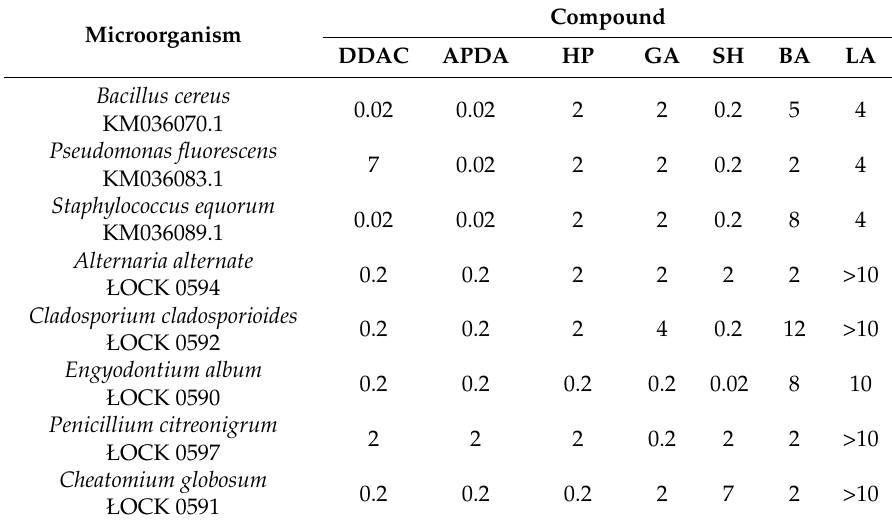
Table 1. Minimal inhibitory concentration of active compounds in % ( v / v